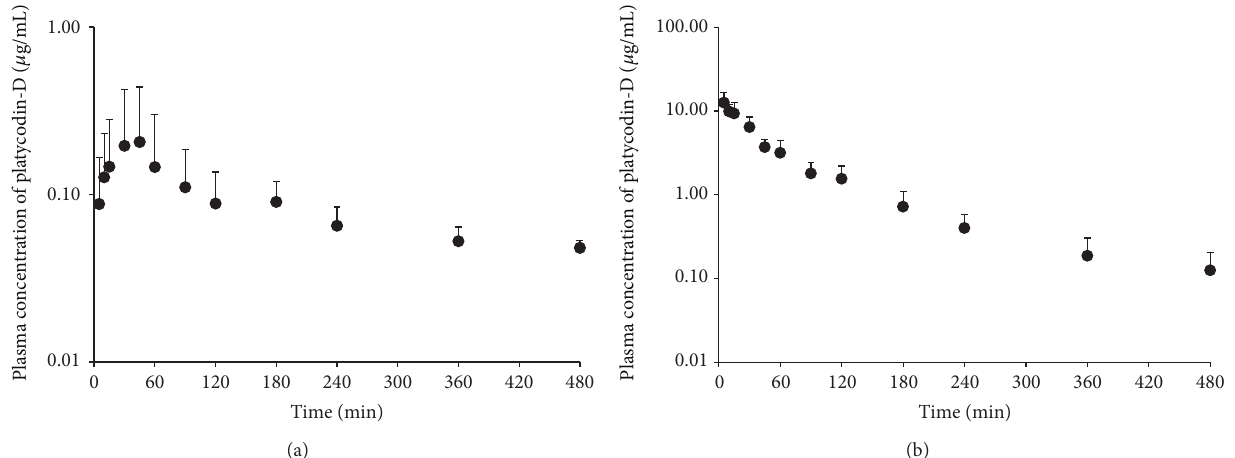
Figure 5: Mean plasma concentration-time profile of PD after intravenous administration of 25 mg/kg and oral administration of 500 mg/kg of PD-3% to rats ( 𝑛 = 4 ). Vertical bar represents standard